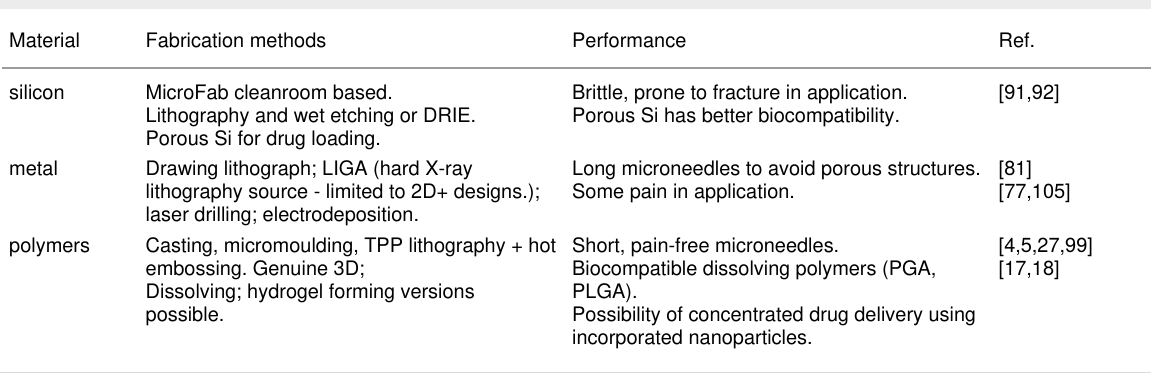
Table 1: Overview of key microneedle